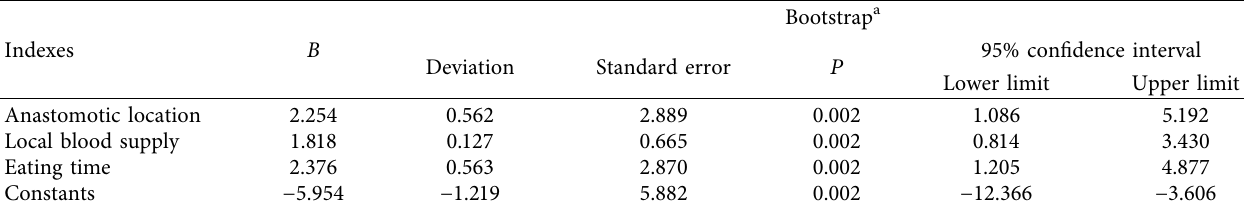
Table 4: Variables in the equation